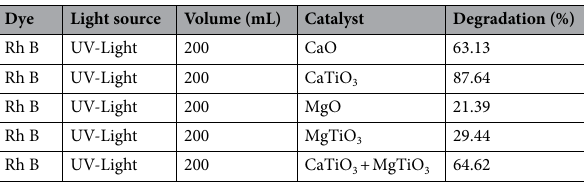
Table 2. Rhodamine B dye decomposition (%).